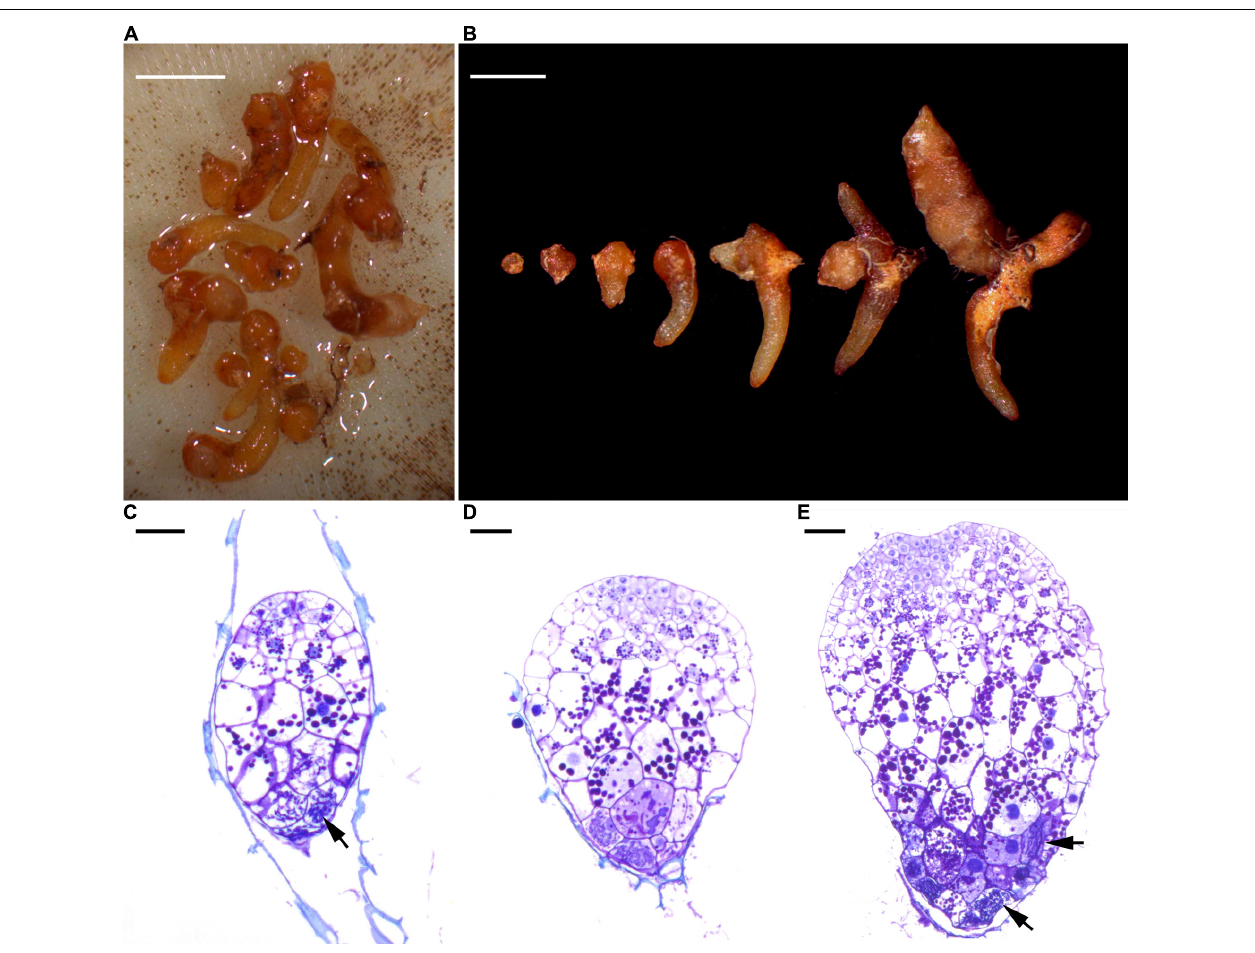
FIGURE 2 | Different stages in the germination process of Gastrodia confusoides seeds and indications of the presence of mycorrhizal fungi. (A) Developing protocorms from a single packet at 12 months after sowing. Scale bar = 2 mm. (B) A selection of different stages of protocorms and young root tubers from the packet. Scale bar = 2 mm. (C) At the early stage of germination, fungal hyphae (arrow) have colonized the basal part of embryo. Scale bar = 50 µ m (D) The enlarged embryo has ruptured the seed coat. Scale bar = 50 µ m (E) The developing protocorm has elongated with the meristematic cells at the up region and the fungal colonization at the basal region. Fungal hyphae (arrows). Scale bar = 50 µ